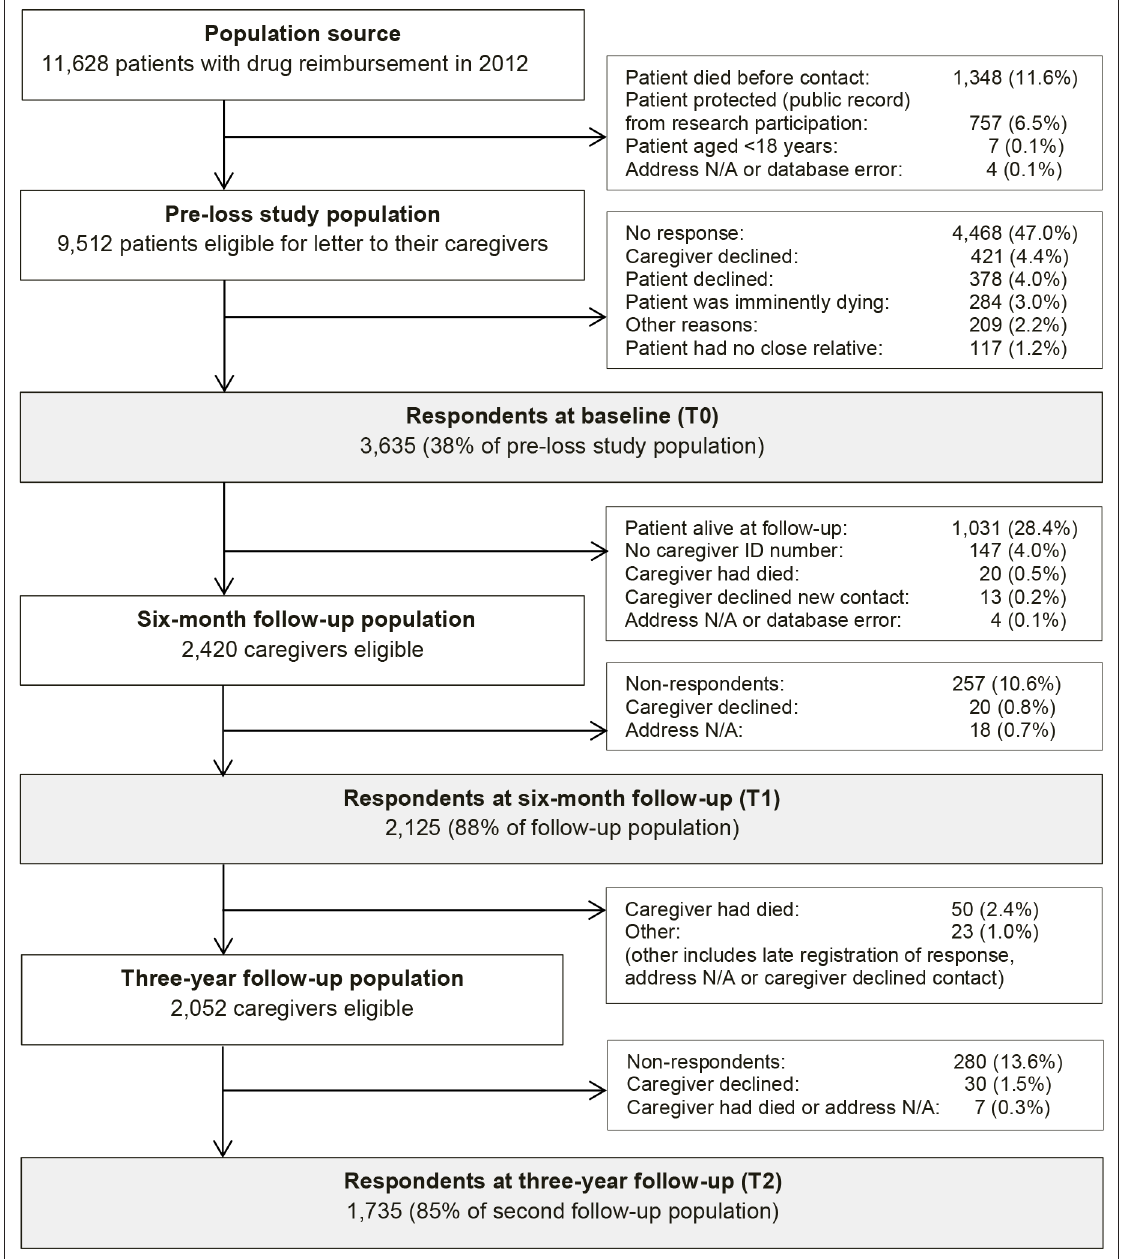
Figure 1 Flow diagram of family caregivers at the time of the patient’s drug reimbursement registration owing to terminal illness (T0), 6 months after the patient’s death (T1), and 3 years after the patient’s death